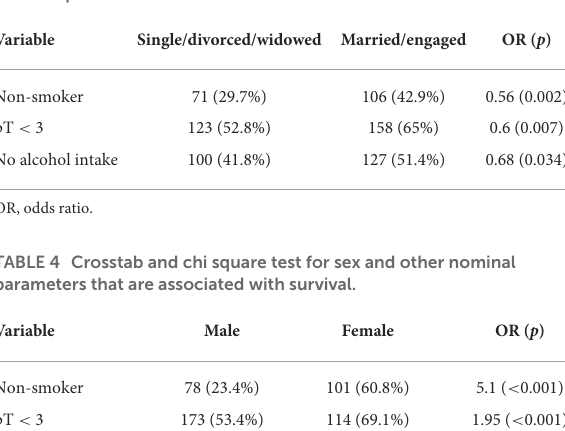
TABLE 3 Crosstab and chi square test for marital status and other nominal parameters that are associated with survival.